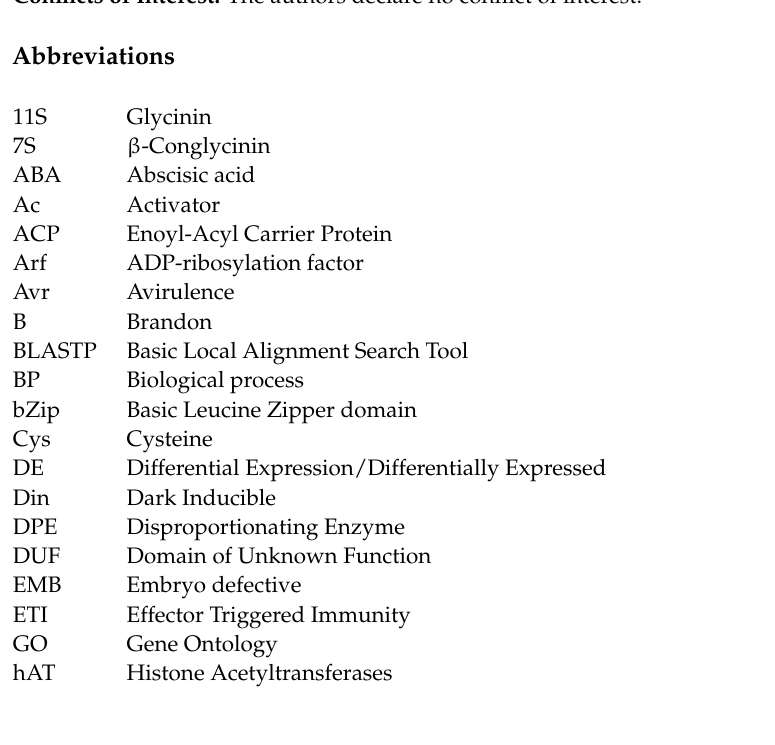
Table S3: Shortlisted differential expressed genes in high TP and high 11S soybeans, including log2fold-change difference in expression across all year-location permutations and gene annotations.; Table S4: Revigo results, indispensable BS GOs up- and downregulated in high TP and high 11S soybeans.; Table S5: The average log2FC DE of soybean samples grown between East (Ottawa) and West (Morden, Brandon, Saskatoon) locations over 2018–2020. Table S6: The total number of remaining DE genes per dataset after trimming at an adjusted p -value below 0.05 and a log2FC DE of at least